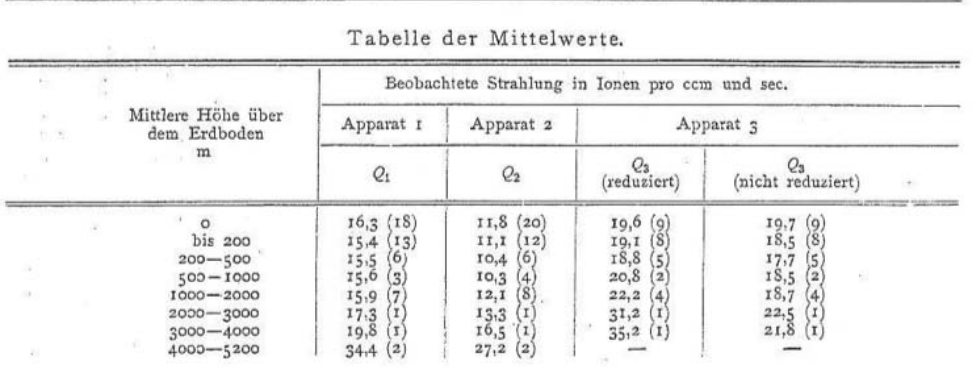
Figure 4. Table from Hess (1912) showing the averaged measured ionization rates (ions cm − 3 s − 1 ) from the three instruments used as a function of altitude. Apparat 1 and 2 are supposed to have measured γ radiation, Apparat 3 a possible β radiation. In parenthesis the number of averaged samples is indicated. The accuracy of the instrument was limited by the imperfect electrical isolation between the filaments and the metal case. From Hess’ instrumental details (Hess, 1912) an uncertainty of 0.3–0.5ionscm − 3 s − 1 can be estimated.